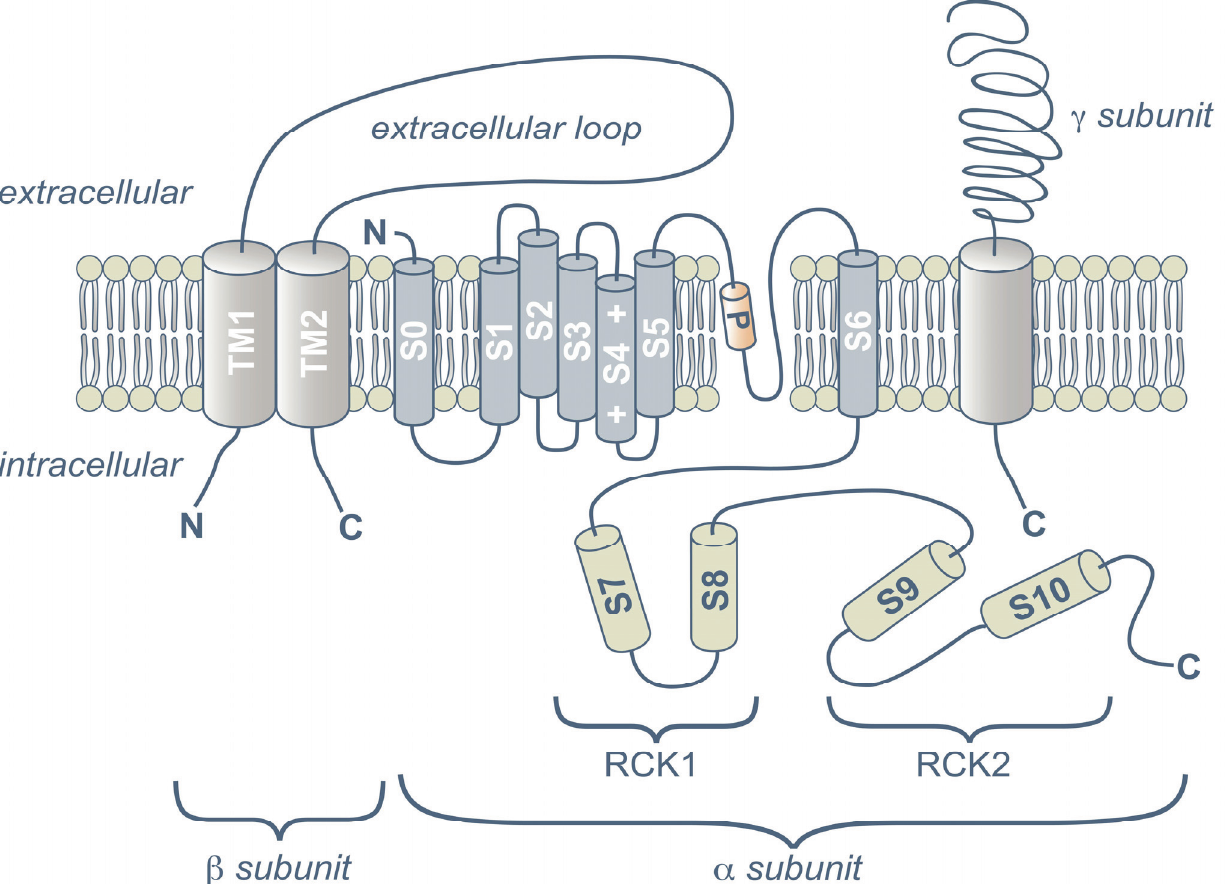
Figure 1. Schematic structure and membrane topology of maxi calcium-activated potassium (BK) channel (cid:3), (cid:4) and (cid:5) subunits (adapted from [44]). See text for a discussion of the